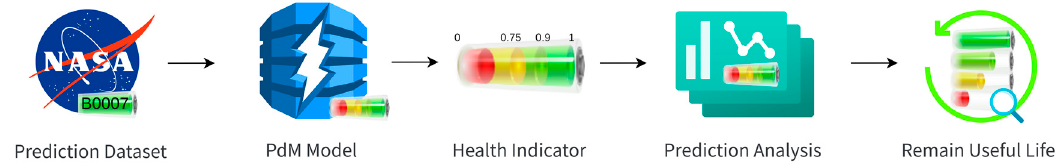
Figure 12. Flow of health indicator and remaining useful